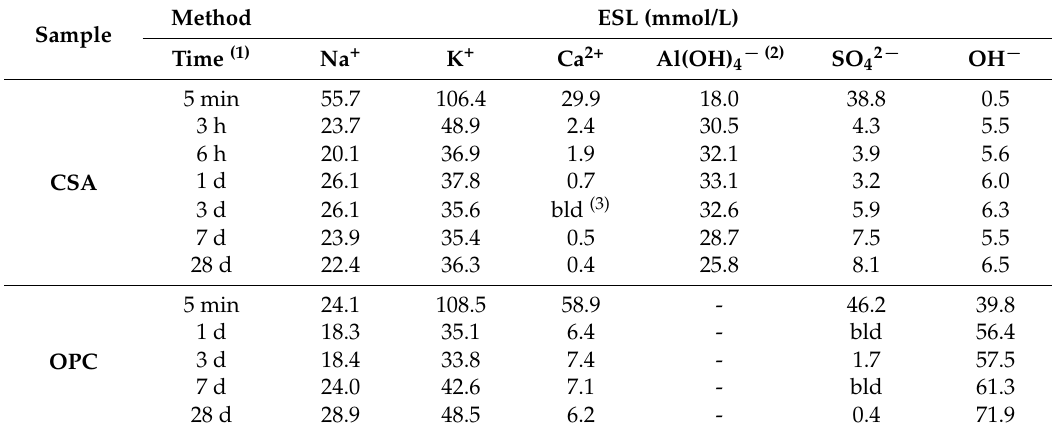
Table 3. Leaching solution chemistry of OPC and